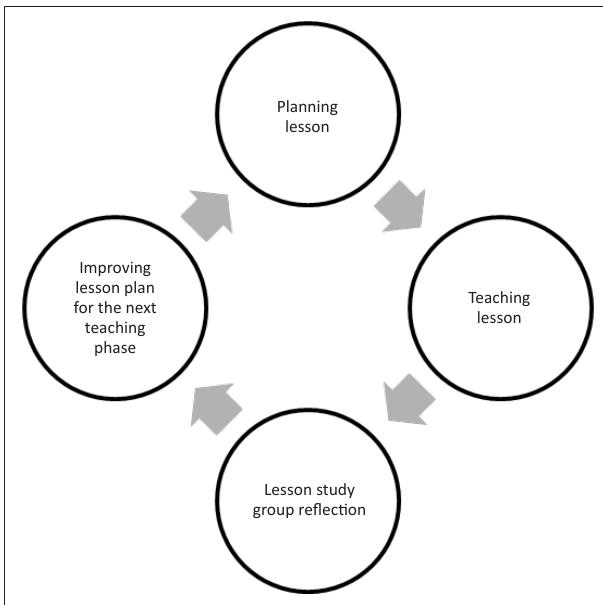
FIGURE 1: Lesson study